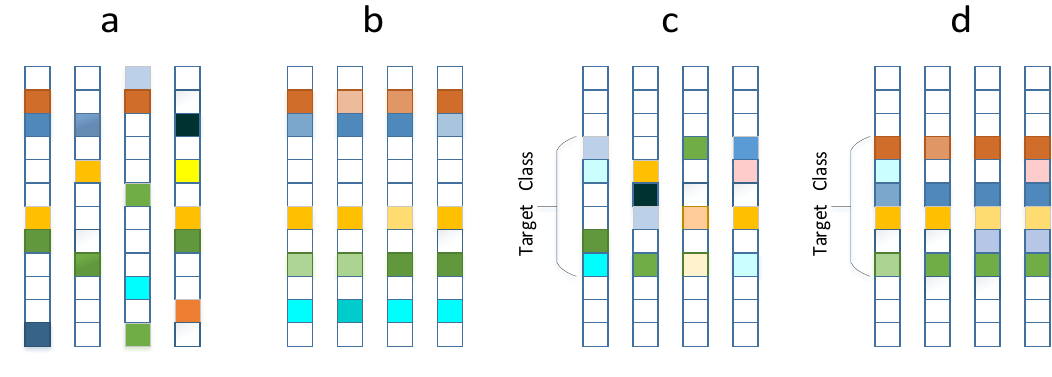
Figure 2. Illustration of different joint sparse representation coefficients. Each column means a representation vector and each square means a coefficient value. White squares denote zero values while colored ones denote nonzero values. ( a ) l 1 -norm induced naïve joint sparsity(as in Equation (1)): simple joint sparse representation without highlighting any intra-set relationships; ( b ) Row-level sparsity (as in Equation (2)): the sparse representation vectors share a exactly the same sparsity pattern, highlighting inter-instance similarity within the query set; ( c ) Class-level sparsity (as in Equation (3)): ideally, the non-zero coefficients fall into a same class block but maybe distribute in disorder, conniving large variations among the images within the query set ; ( d ) The proposed class-level sparsity with low rank regularization (as in Equation (4)): the non-zero coefficients fall into a same class block and distribute in order with slight anomaly, revealing both the commonality and the variations across images within the query